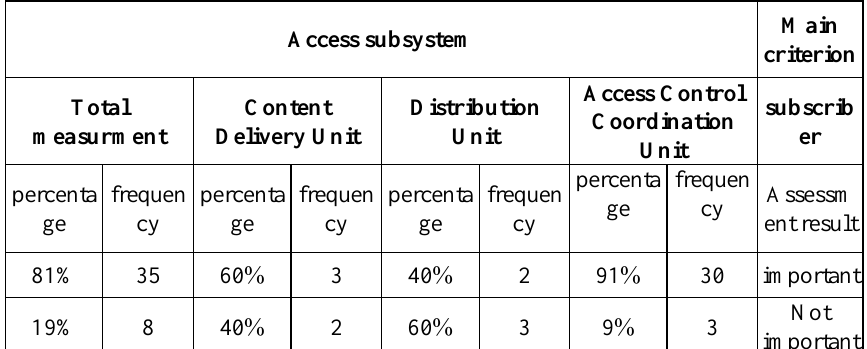
Table 6. Survey of access